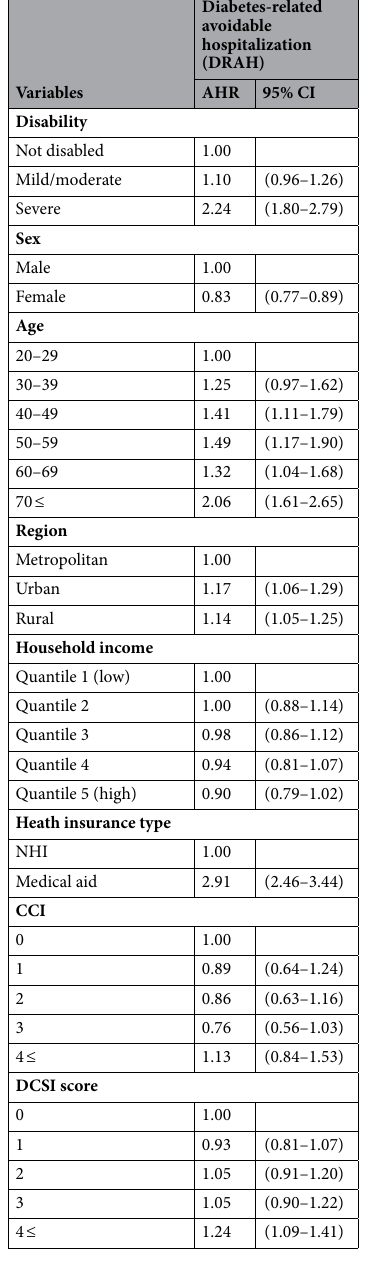
Table 2. Diabetes-related avoidable hospitalization hazard ratio, results of Cox proportional hazard model. AHR Adjusted Hazard Ratio, NHI National Health Insurance, CCI Charlson Comorbidity Index, DCSI Diabetes Complications Severity